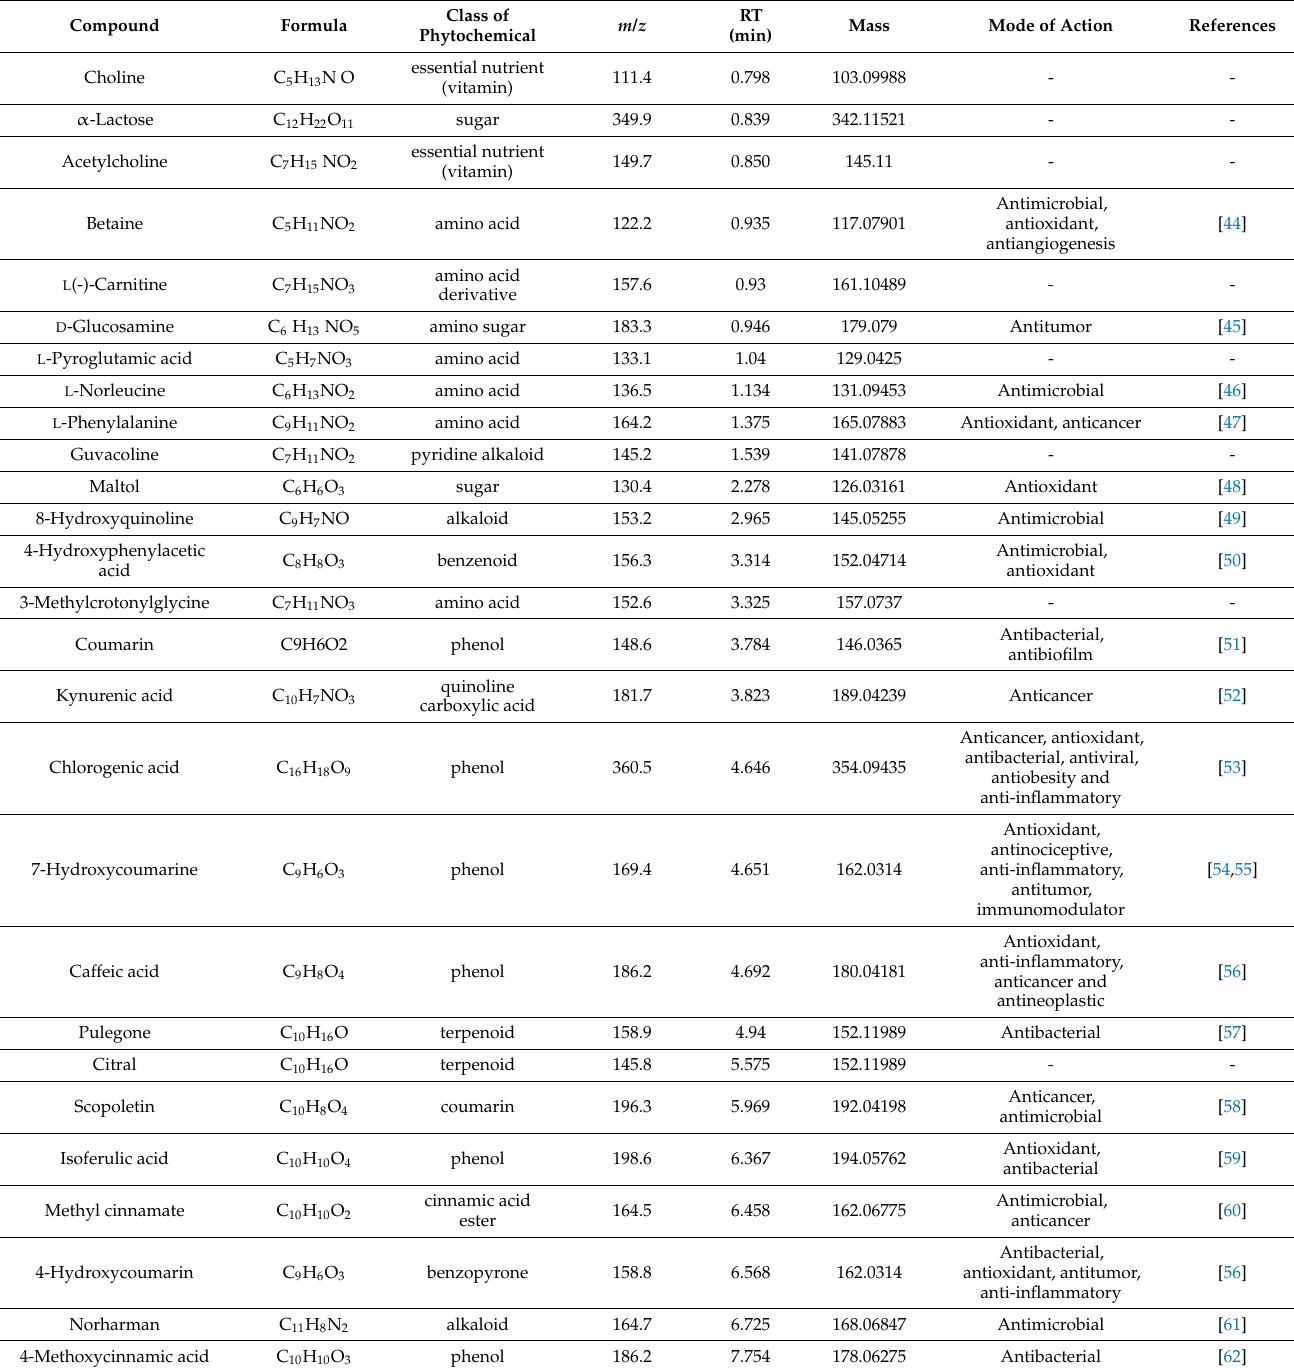
Table 2. Profiling of bioactive compounds present in S. repanda crude extract with their biological